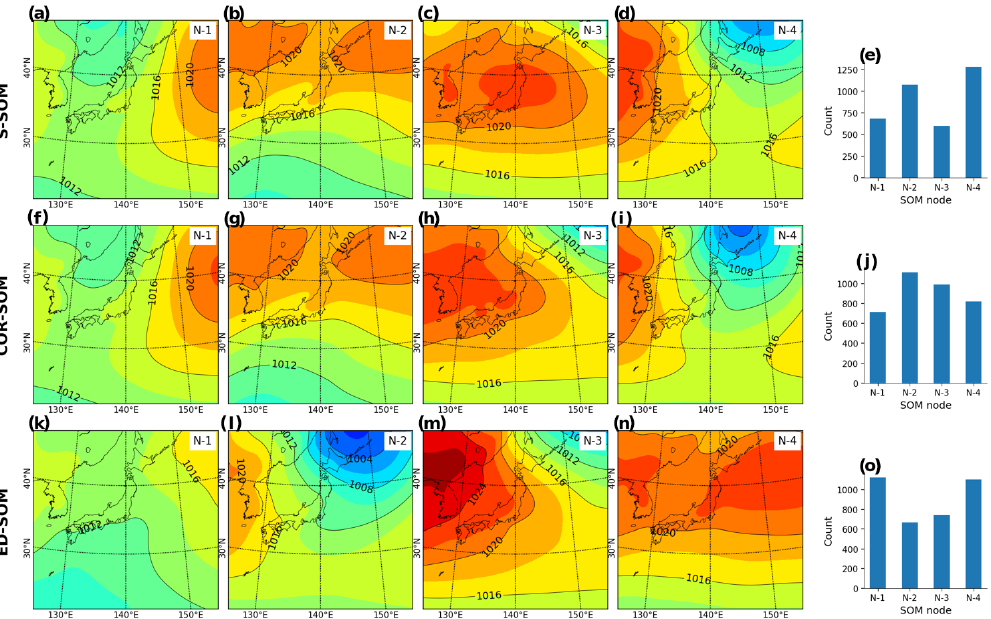
Figure A4. Autumn (SON) MSLP pattern revealed by SOMs. Panels (a) – (d) show S-SOM patterns (with four nodes); panel (e) shows the number of daily MSLPs classified as nodes 1 to 4. Panels (f) – (i) show the same result but for COR-SOM; (k) – (o) for